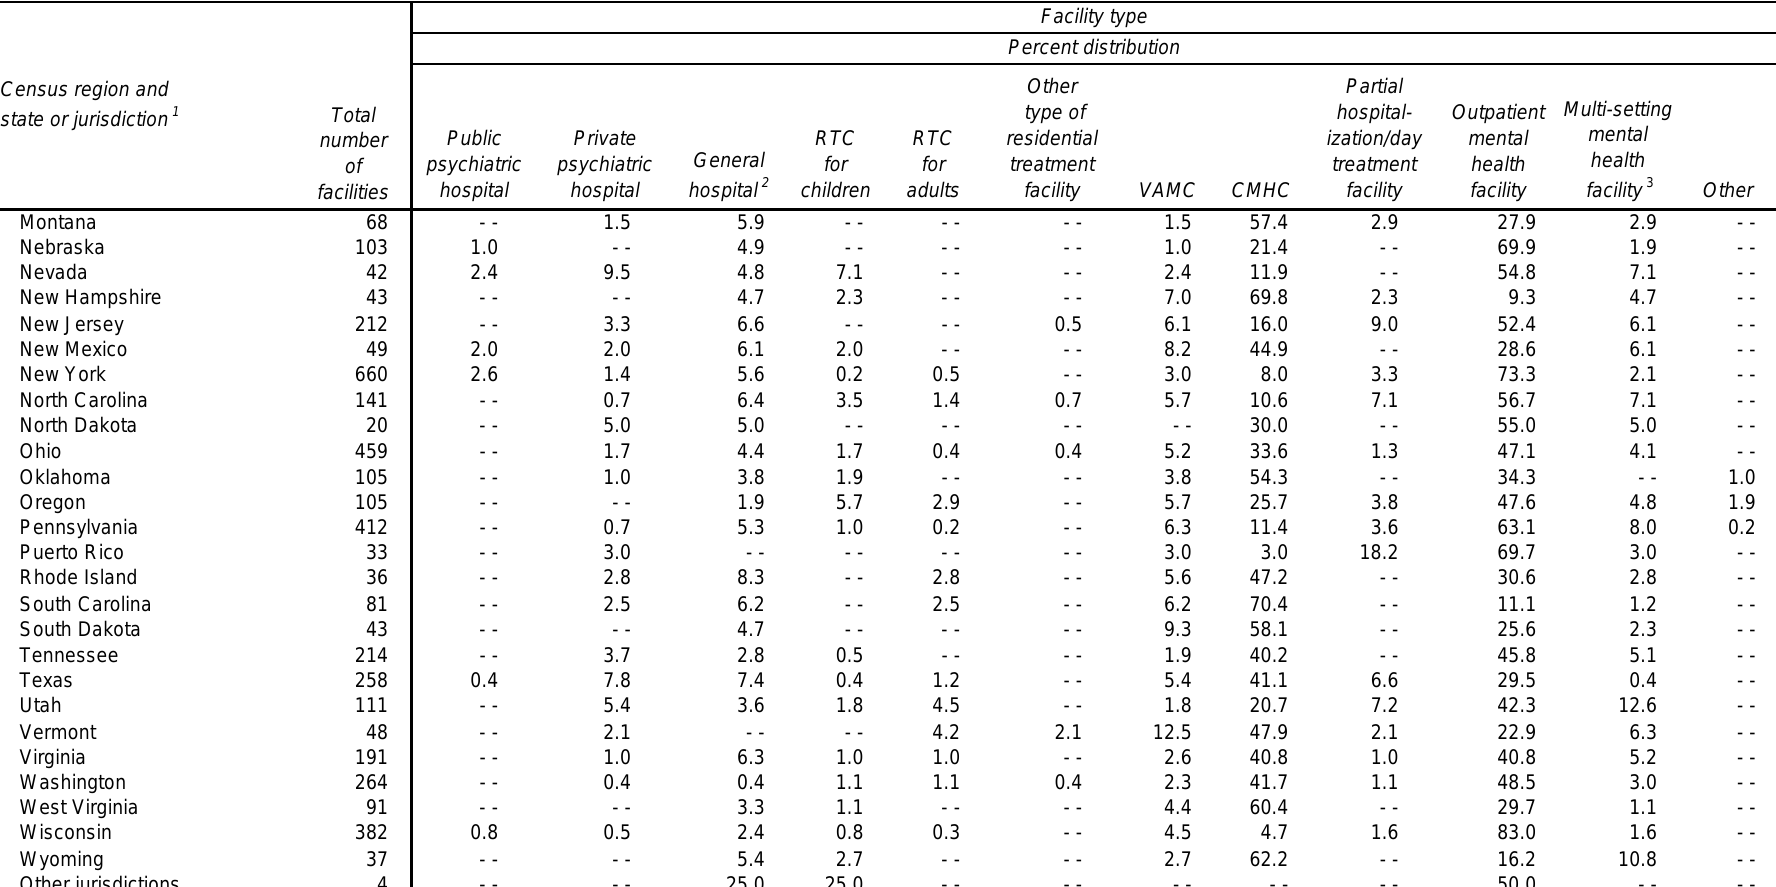
Table 3.6b. Mental health treatment facilities providing less than 24-hour outpatient treatment, by facility type, Census region, and state or